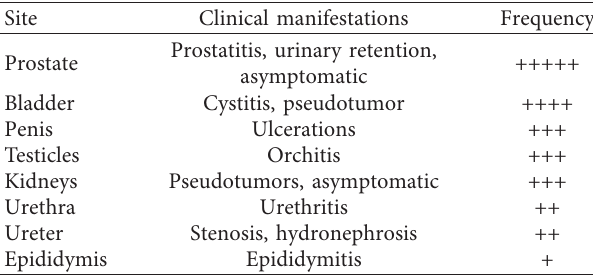
Table 2: Relative frequency of the different urogenital manifes- tations of granulomatosis with